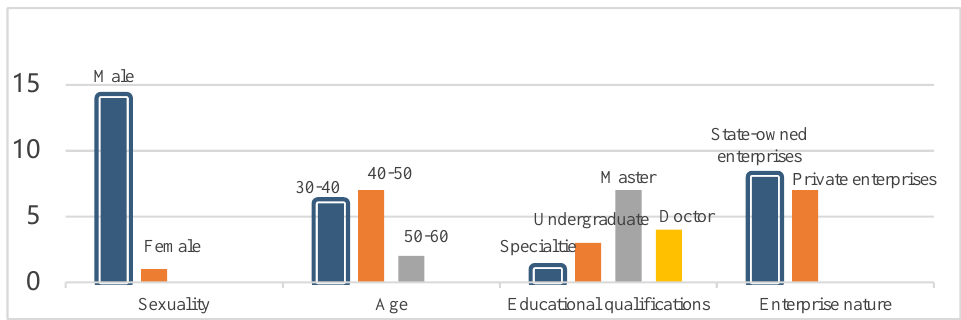
Figure 1. Basic information of interviewees.